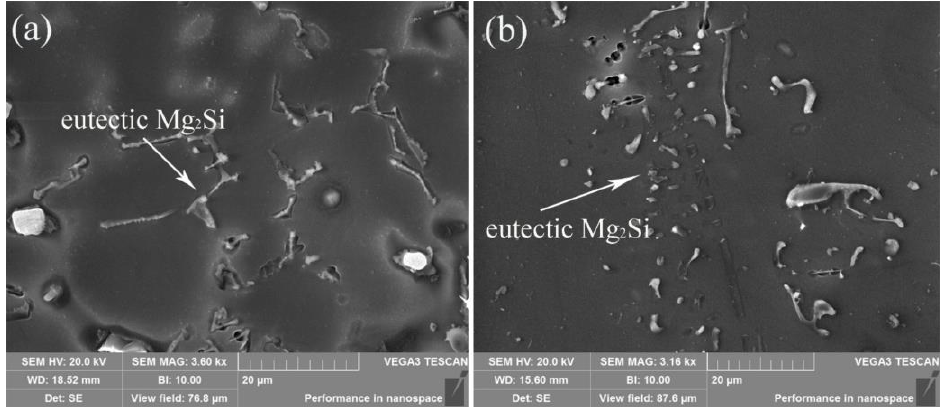
Figure 5. SEM micrographs of the eutectic Mg 2 Si phases in the ( a ) as-cast composites; and ( b ) solution-treated composites.